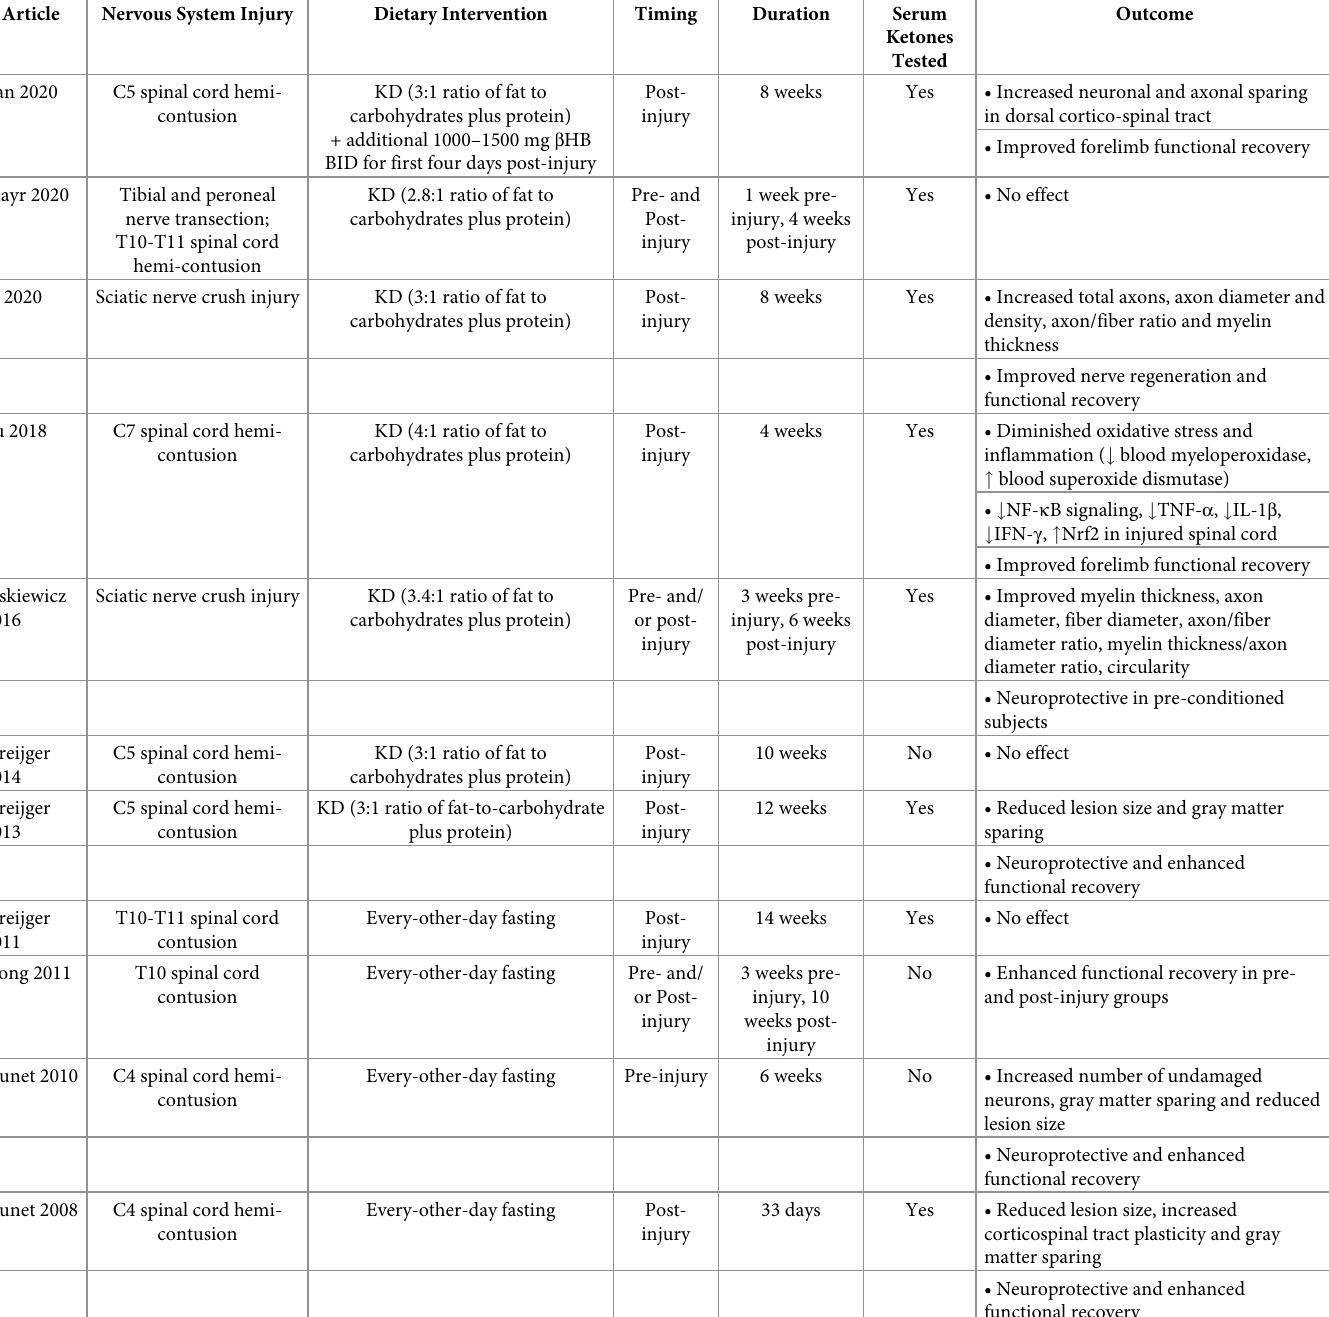
Table 1. Summary of articles. Articles included in the qualitative analysis were organized by type of nervous system injury, dietary intervention, timing of diet initiation relative to injury, duration of dietary intervention, whether or not serum ketones were measured, and brief summary of